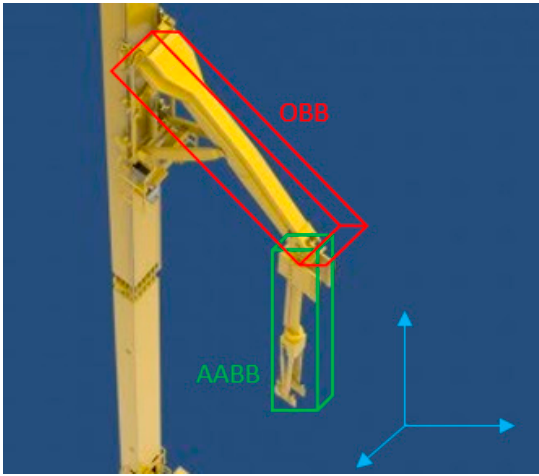
Figure 4. Axis-aligned bounding box and oriented bounding box of objects.